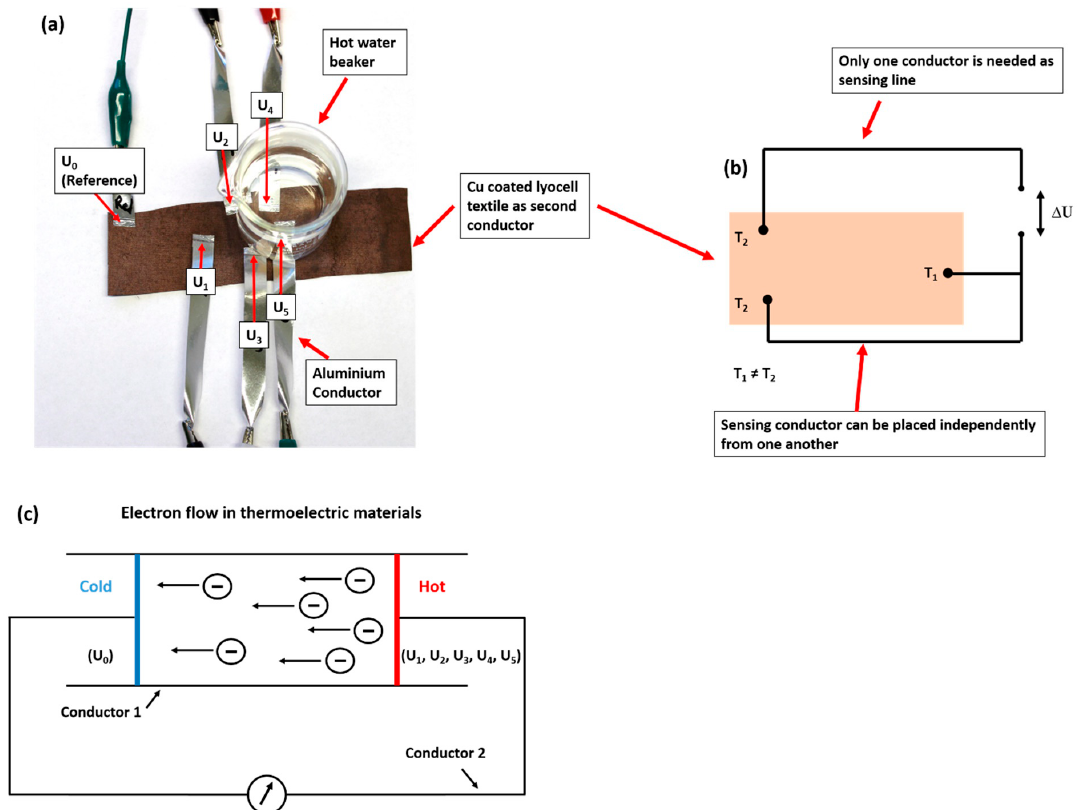
Figure 4. The construction of five thermocouple pairs ( a ), the description of electron flow in thermoelectric materials ( b ) according to [12], and ( c ) an electrical circuit. U 0 is the reference junction and U 1 , U 2 , U 3 , U 4 , and U 5 are measuring junctions.